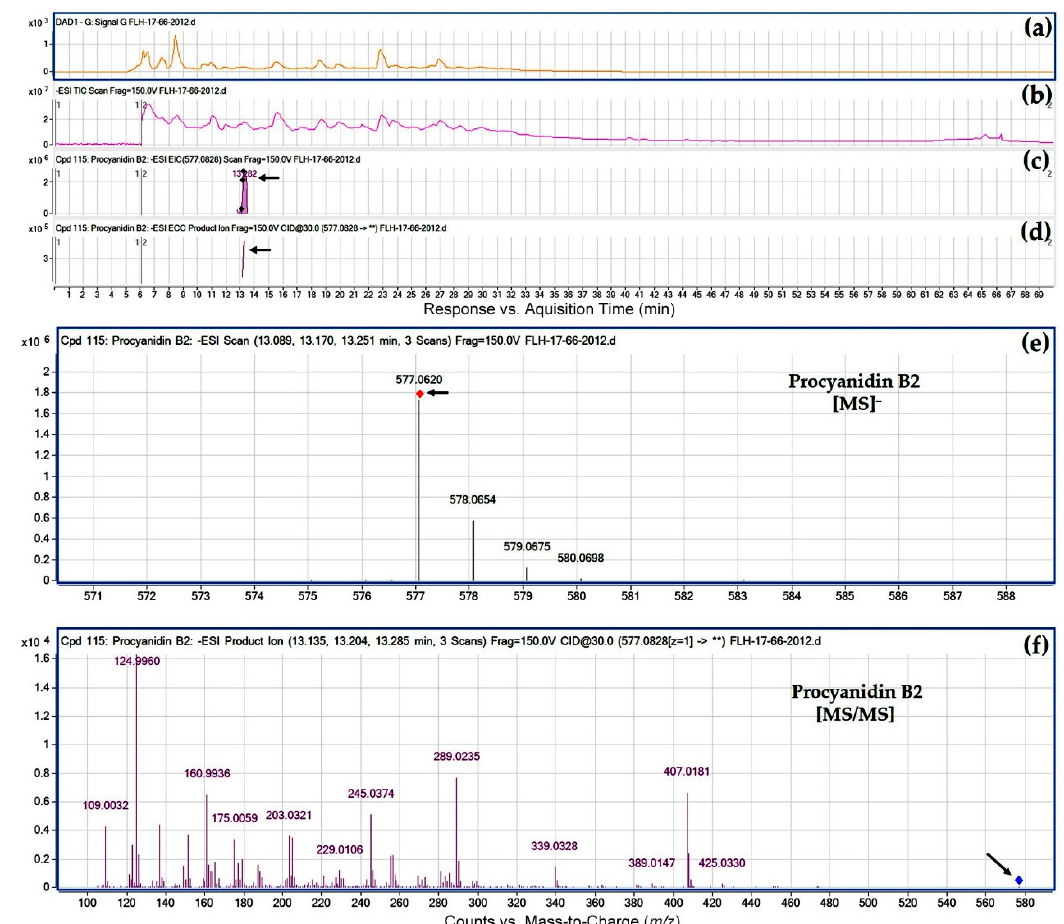
Figure 10. Extracted ion chromatogram (EIC) of primary mass spectrum (MS1) and m / z features of secondary ion fragments (MS2) derived from LC-MC/MS annotate this peak to be procyanidin B2 (MW, 578.52). ( a ) Chromatogram of FLH 17-66 extract (2012) recorded at 280 nm; ( b ) total ion chromatogram of FLH 17-66 extract (2012); ( c ) EIC of primary ion 577.0828 [M − H]¯; ( d ) enhanced charge capacity (ECC) ion product for m / z 577.0828; ( e ) a MS profile showing an extracted m / z value, 577.0620; and ( f ) fragments from collision-induced dissociation (CID) of m / z 577.0620 showing m / z 109.0032, 124.9960, 136.9946, 151.0073, 160.9936, 245.0374, 289.0235, 407.0181, and 425.0330 (Table 1).